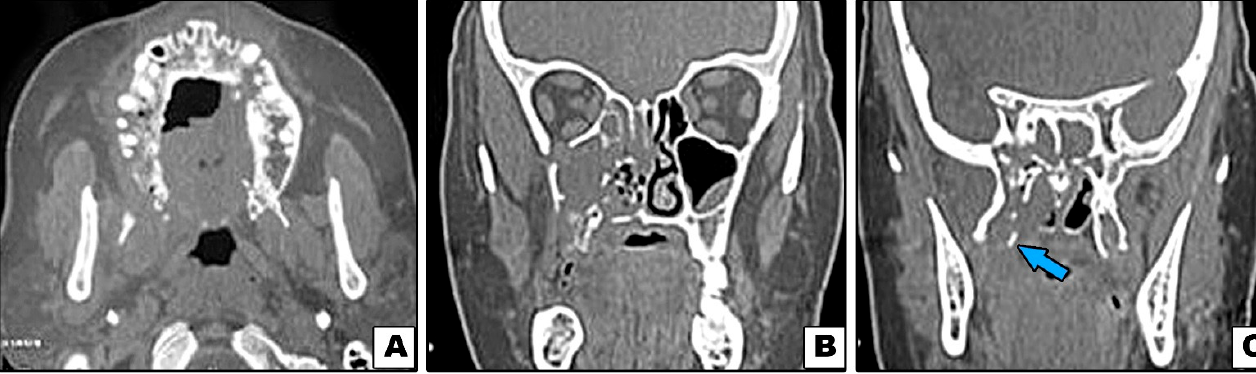
Figure 5. Case#13: ( A – C ) Axial and coronal CT showing bone destruction involving premaxilla, right maxilla with pterygoid plates (arrow), and not involving inferior orbital rim.